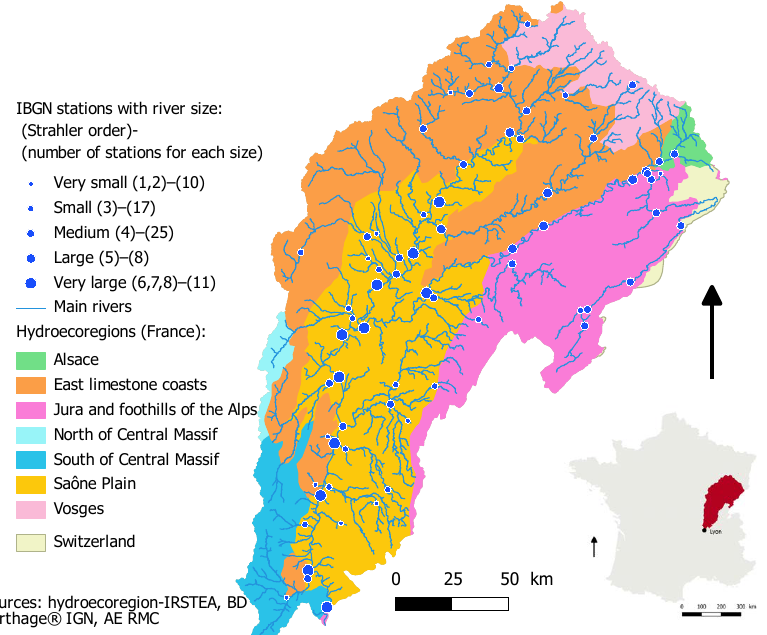
Figure 1. Saône basin: hydroecoregions, main rivers and IBGN monitoring stations network. Each station is localised by a blue point and ranked by the river size: the more the point is big, the more the river is large. For each river size, Strahler orders and IBGN stations count are mentioned into the first and second brackets